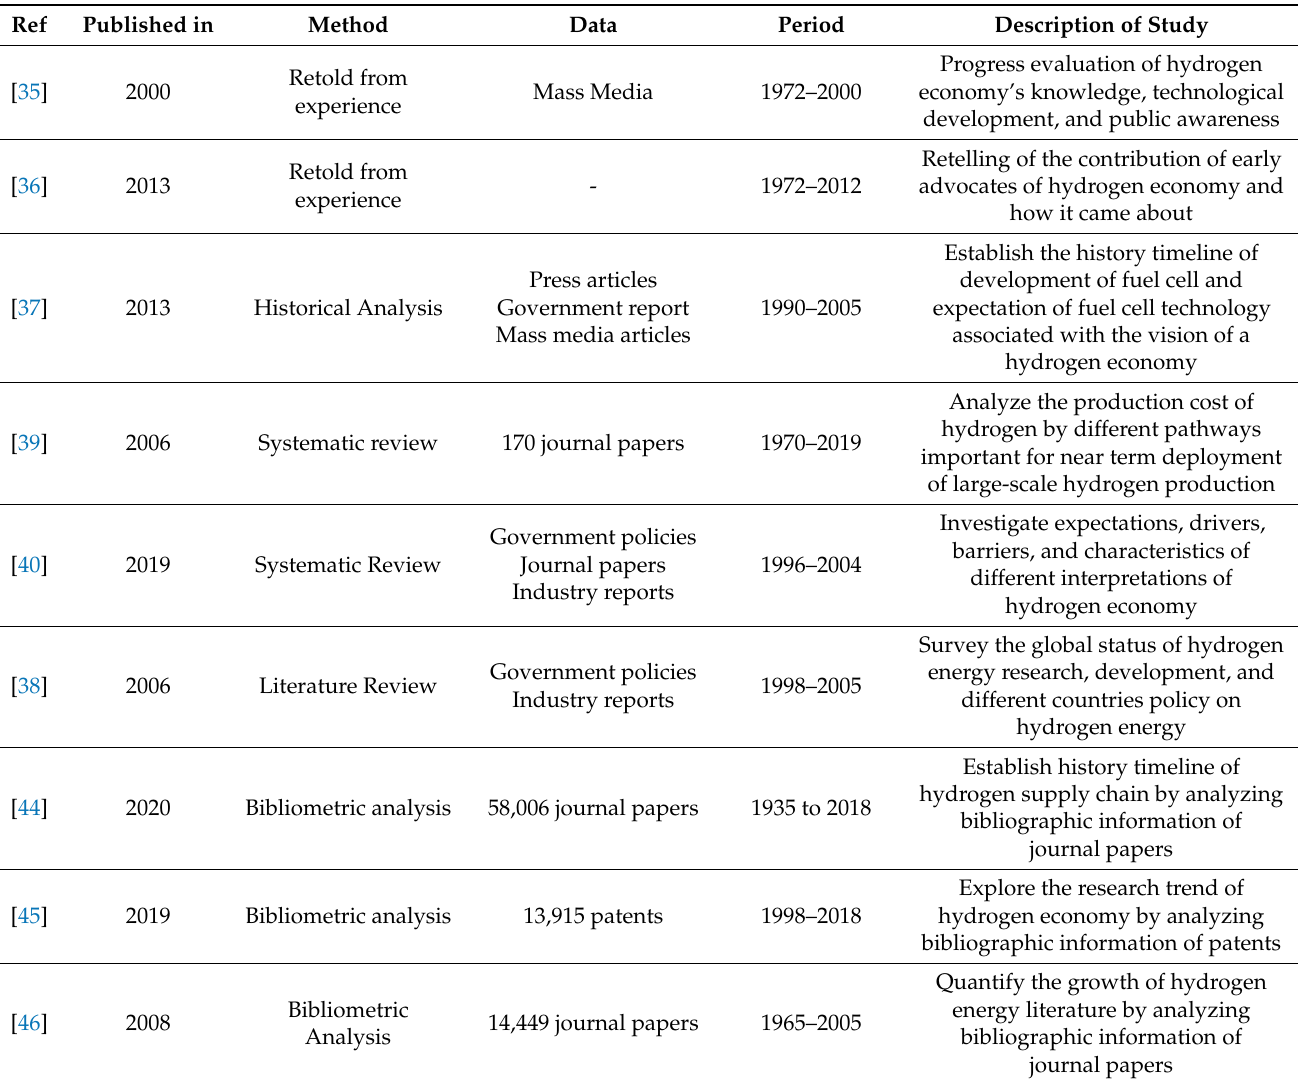
Table 1. Summary of Literature Review—Studies analyzing hydrogen technologies and hydrogen economy